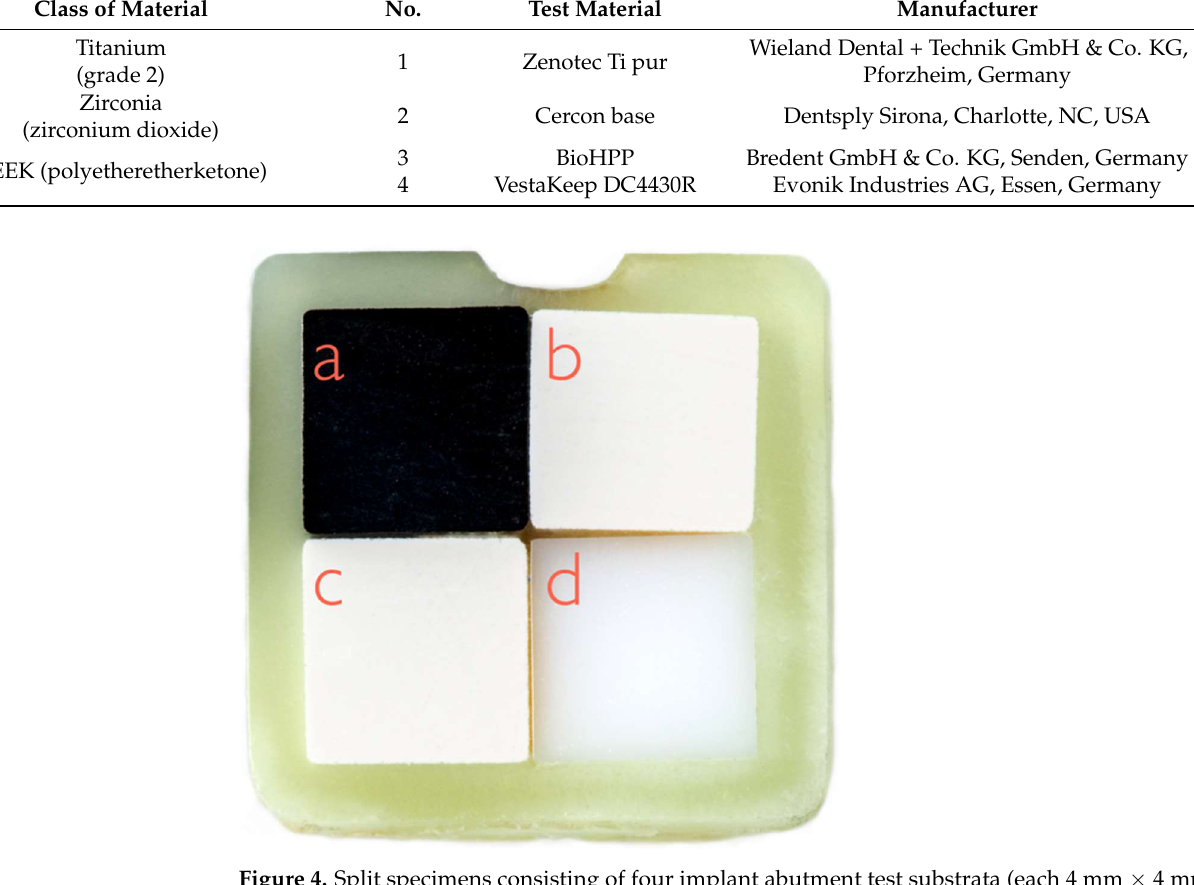
Figure 4. Split specimens consisting of four implant abutment test substrata (each 4 mm × 4 mm): titanium ( a ), zirconia ( b ), PEEK-BioHPP ( c ), and PEEK-VestaKeep DC4430R ( d ).